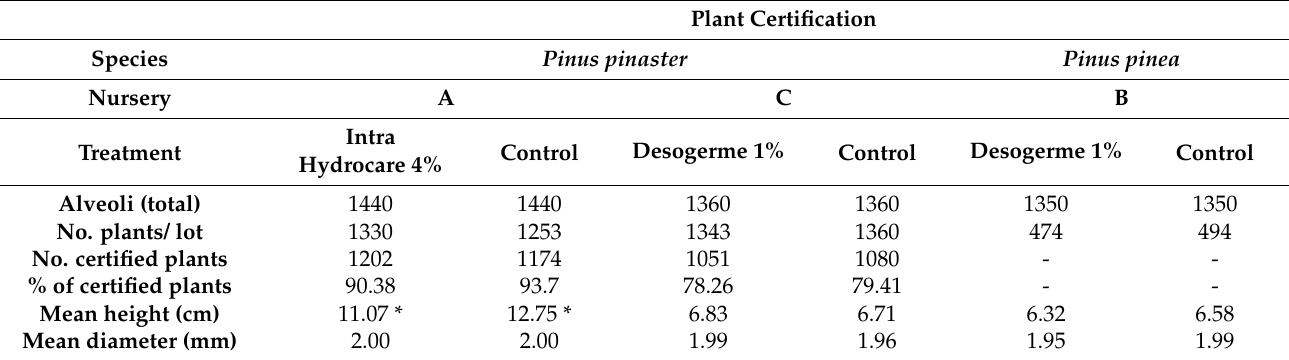
Table 5. Number of certified plants per nursery, species and treatment. Per nursery, mean height and mean diameter data followed by * were significantly different according to a t -test ( p <